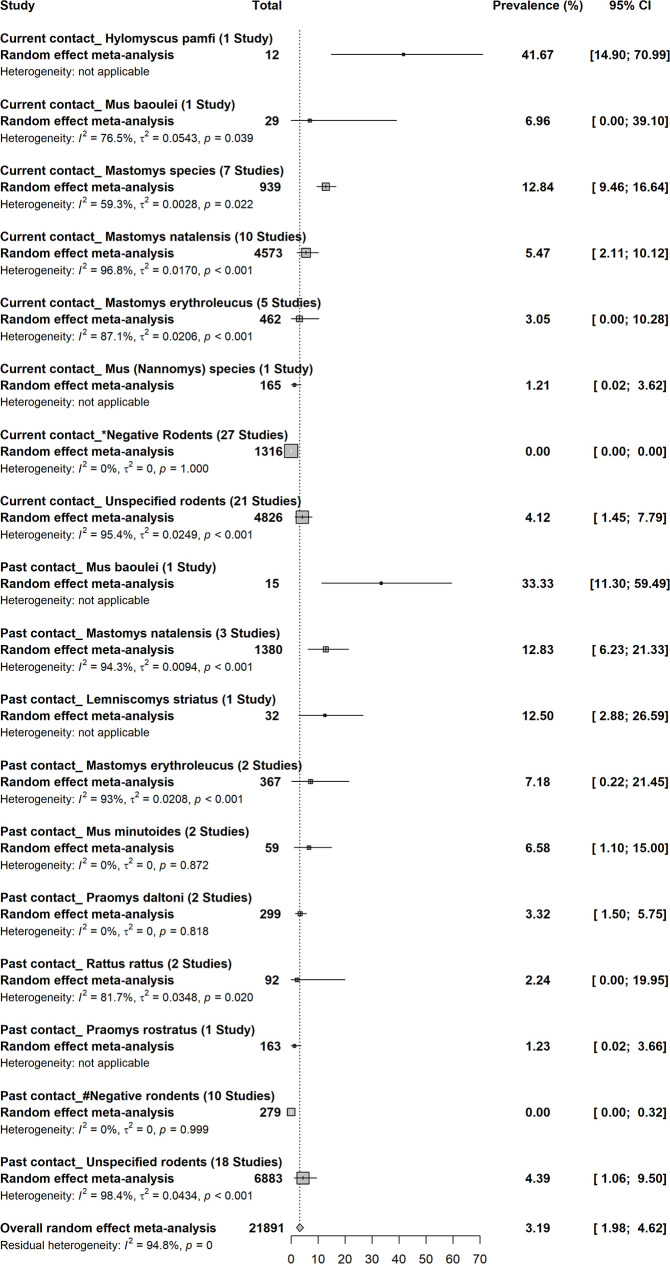
Prevalence of Lassa virus infections in rodents in sub-Saharan Africa.*Negative rodents include Gerbilliscus species, Lemniscomys species, Praomys daltoni, Praomys species, Rattus rattus, Uranomys ruddi, Nannomys minutoides/mattheyi, Myomys daltoni, Praomys rostratus, Lemniscomys striatus, Praomys cf. rostratus, Crocodura species, Lophuromys sikapusi, Tatera cf. guinea, Gerbilliscus kempi, Praomys jacksoni, Mus setulosus, and Mus minutoides. #Negative rodents include Gerbilliscus kempi, Mus setulosus, Praomys jacksoni, Lemniscomys bellieri/zebra, Uranomys ruddi, Crocidura buettikoferi, Gerbilliscus guineae, Lophuromys sikapusi, and Mus mattheyi.